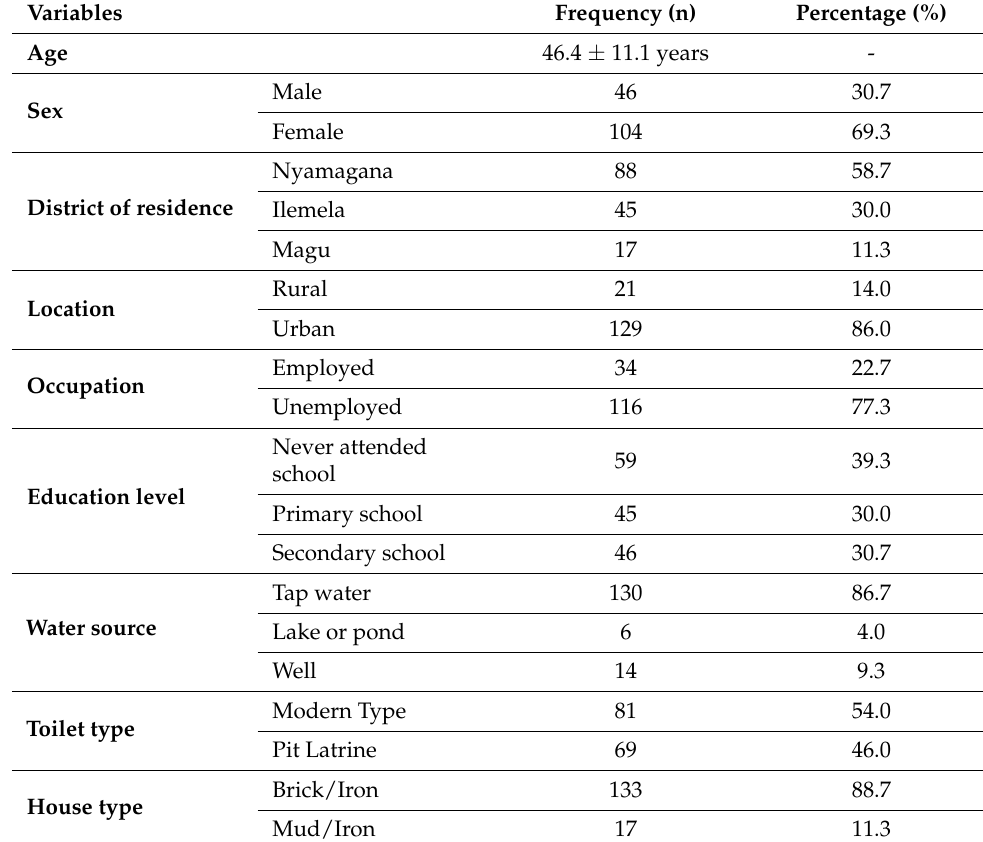
Table 1. Sociodemographic characteristics of enrolled participants.